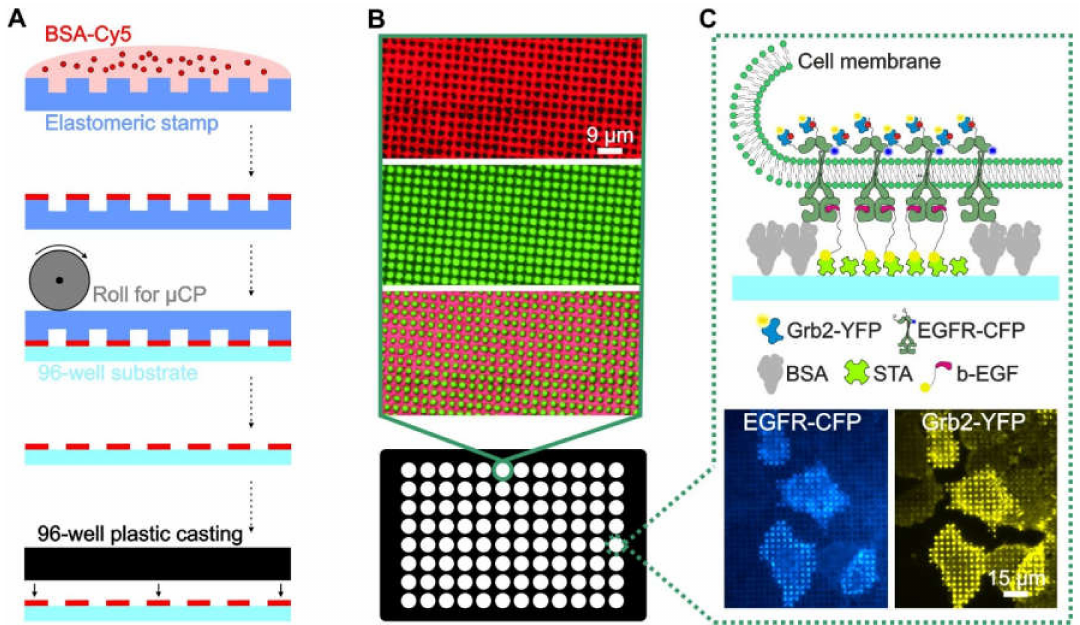
Figure 1. Overview and workflow of the live cell micropatterning approach. ( A ) Schematic illustration of the µ CP procedure using a large-area polymeric stamp. ( B ) Total internal reflection fluorescence (TIRF) microscopy images of a single well of the ready-to-use 96-well plate. Representative images of the BSA-Cy5 grid (red, top), FITC-labeled biotinylated antibody (green, middle) and merged images (bottom) are shown. ( C ) Schematic illustration and representative images of a selected bait-prey interaction detected on the micropatterned surface. Anti-bait protein (biotinylated EGF) was arranged in regular patterns, and the bait protein (EGFR) was reorganized according to the anti-bait molecules. The prey protein (Grb2), therefore, localizes according to the bait patterns, which indicates the close proximity and / or an interaction between the bait and prey. Specific enrichment can be visualized using fluorescently tagged bait / prey molecules such as EGFR-CFP and Grb2-YFP. Abbreviations: BSA, bovine serum albumin; b-EGF, biotinylated EGF; STA, streptavidin; and µ CP, microcontact printing. Illustrations are not drawn to